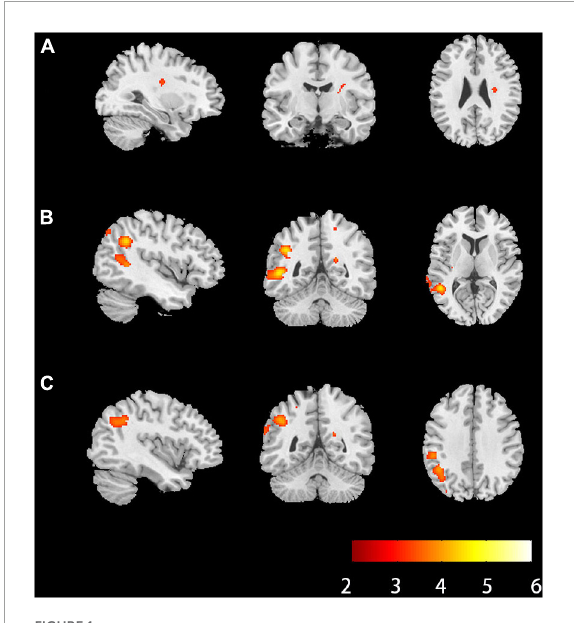
FIGURE1 Brain regions of anti-NMDAR encephalitis patients showed significant microstructural changes. (A) Brain regions where radial kurtosis (RK) values changed in the white matter ( P < 0.001, uncorrected, cluster size = 30). (B) Brain regions where kurtosis fractional anisotropy values changed in the gray matter ( P < 0.001, uncorrected, cluster size = 30). (C) Brain regions where RK values changed in the gray matter ( P < 0.001, uncorrected, cluster size = 30). The hot color represents the lower diffusion parameters values in the patients’ group. L, left; R, right; anti-NMDAR, anti-N-methyl-D-aspartate